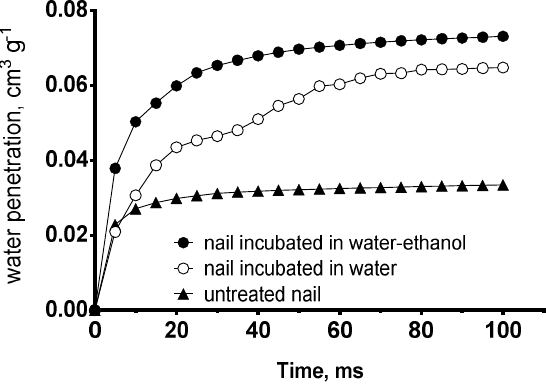
Figure 3. Rate of water penetration into the structural models corresponding to untreated nails and nails incubated in water and in water-ethanol 50% predicted by PoreXpert ® models. Water penetration is expressed as cm 3 of water penetrated into one gram of nail.